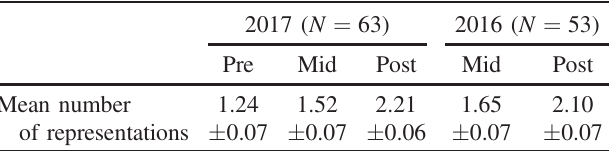
TABLE III. The mean number of representations (graphs, mathematics, text) used per assessment item in the pre-, mid-, and post-test responses. Errors are the standard errors on the mean.